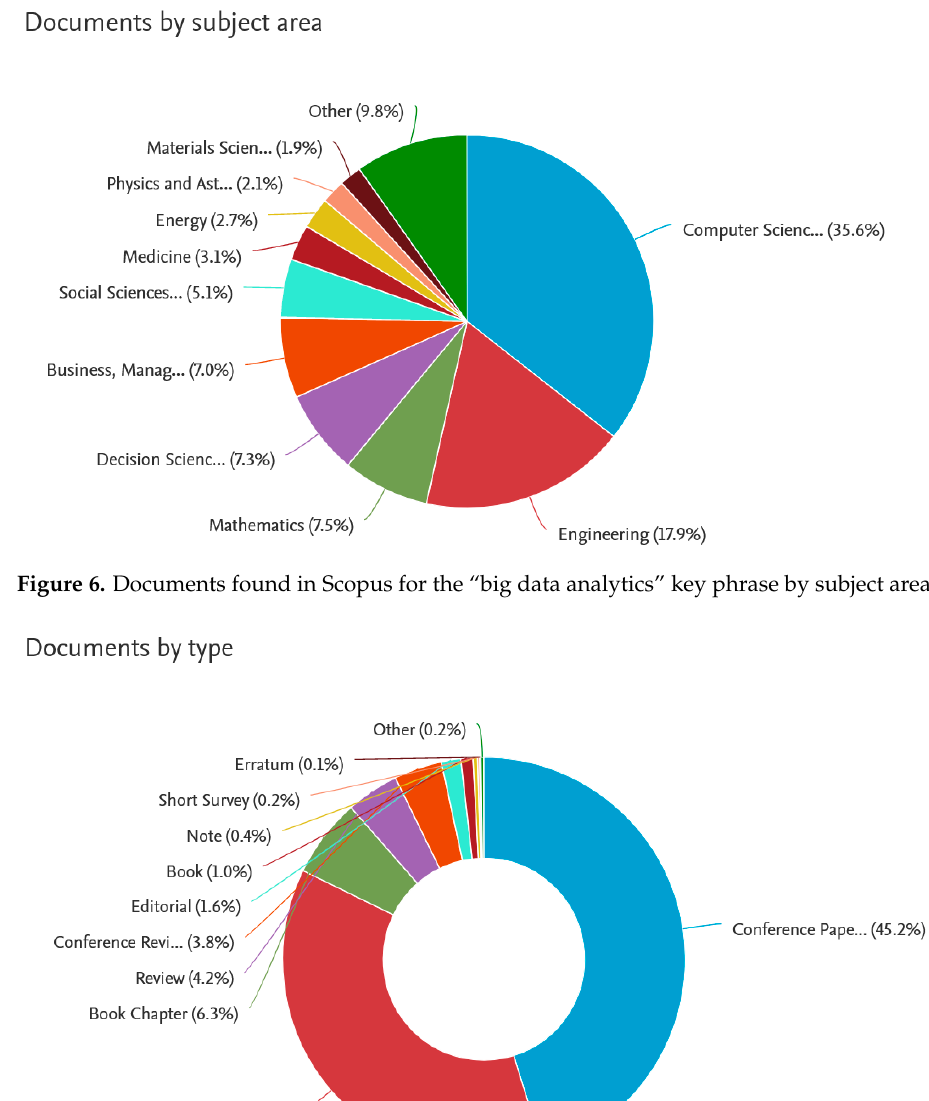
Figure 5. Documents found in Scopus for the “big data analytics” key phrase by year of publication.